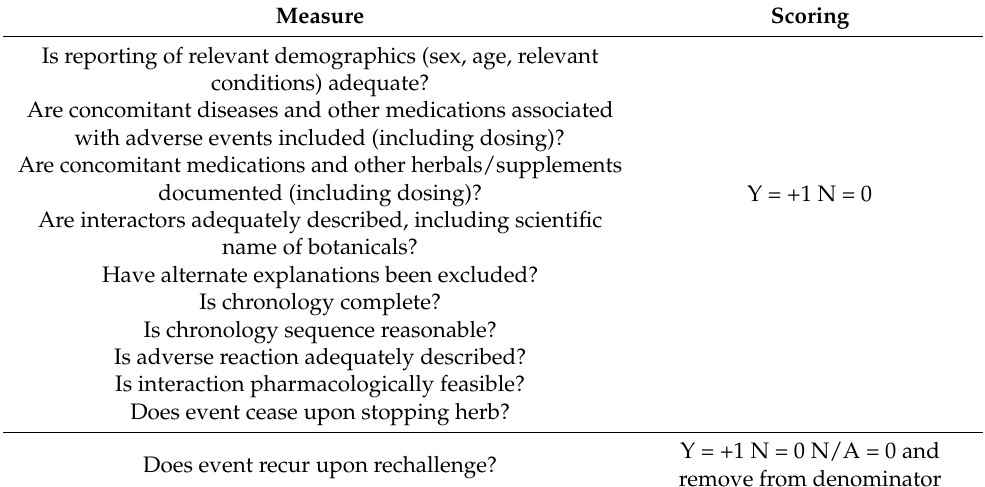
Table 1. Case report completeness rating tool, adapted from reference [32].